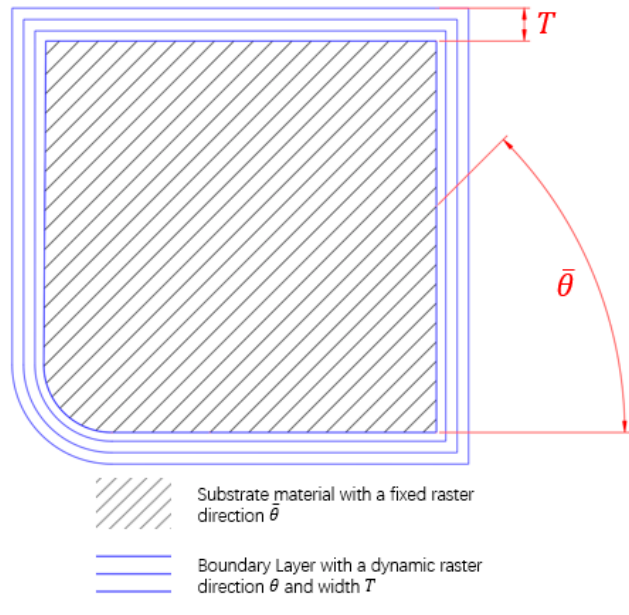
Figure 1. The hybrid deposition paths.